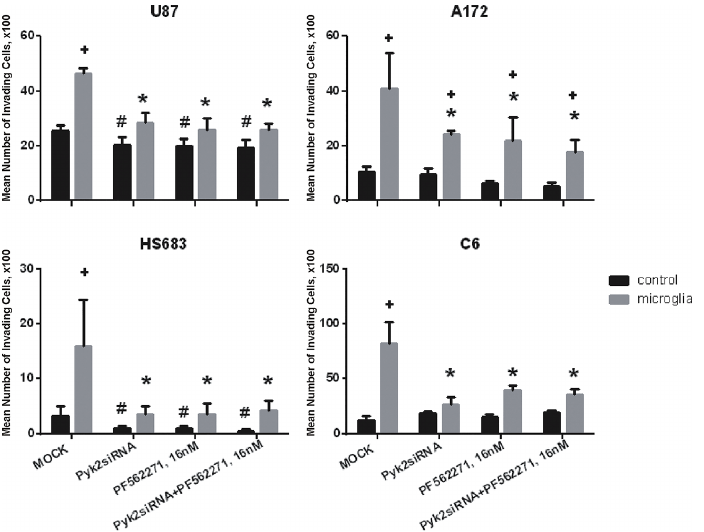
Fig 7. siRNA knock-down and/or pharmacological blockade of Pyk2 by PF-562,271 eliminates the stimulatory effect of microglia on glioma cell migration. Data obtained from standard migration assays for control glioma cells and cells transfected with siRNA against Pyk2 with and without additional application of PF-562,271 in the presence and absence of microglia in the lower compartment. Due to different migration abilities in all presented cell lines the Y-axis scales are adjusted for each cell line in order to demonstrate the absolute numbers of migrating cells. Results are presented as mean ± S.D. with significant difference from control in each group (+), from Mock without microglia on the bottom (#), or from Mock with microglia on the bottom ( * ) (p < 0.05). One-way ANOVA followed by the Tukey ’ s multiple comparison test was used to determine significance between